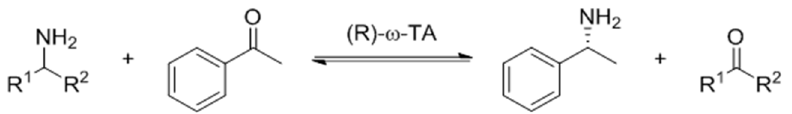
Table 2. The kinetic constants of the wild-type and four stabilized mutant AT-ATAs. Name